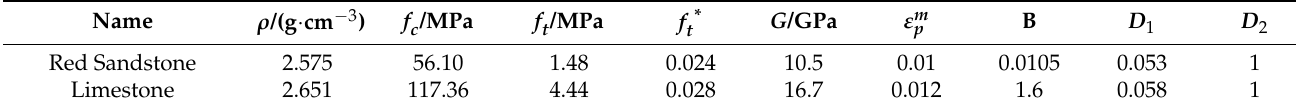
Table 6. Main parameters of limestone and red sandstone materials.